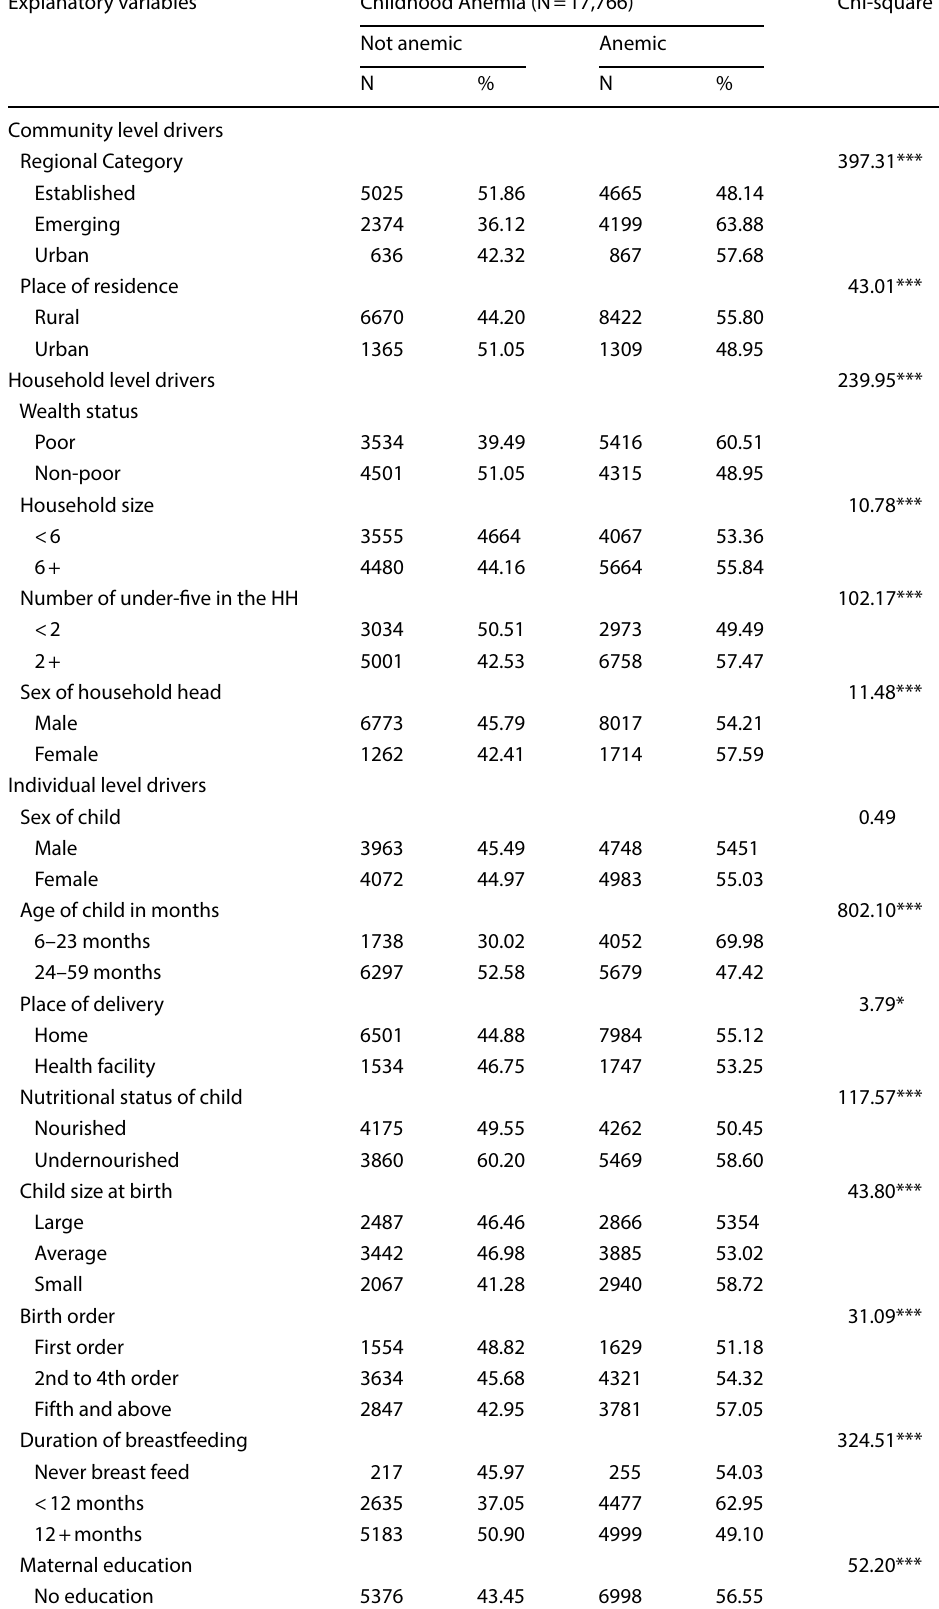
Table 2 Bivariate analysis of explanatory variables